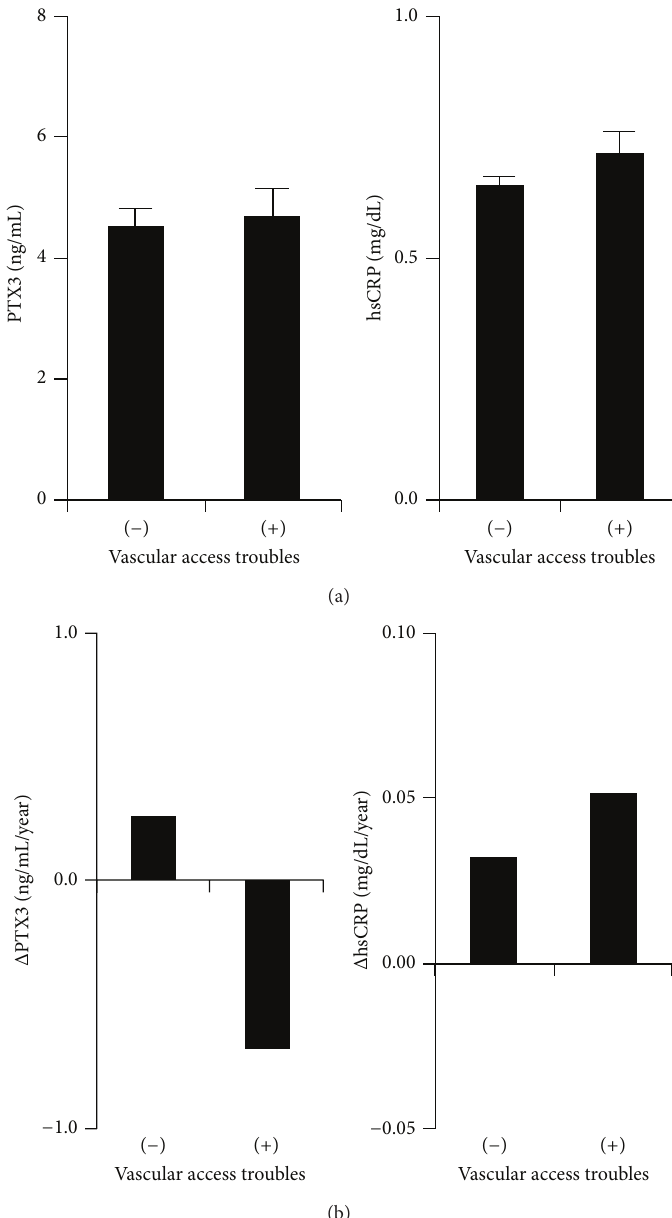
Figure 2: Baseline levels and annual change in pentraxins in subjects with vascular access troubles. Mean ± S.E.M. in baseline year (a) or annualchange(b)ofpentraxinsinthesubjectswithoutorwithvascularaccesstroubles( − or+, 𝑁 = 56 or20,resp.)occurredduringfollow-up years. Significant difference of each parameter between the subjects without or with vascular access troubles was examined by Mann-Whitney 𝑈